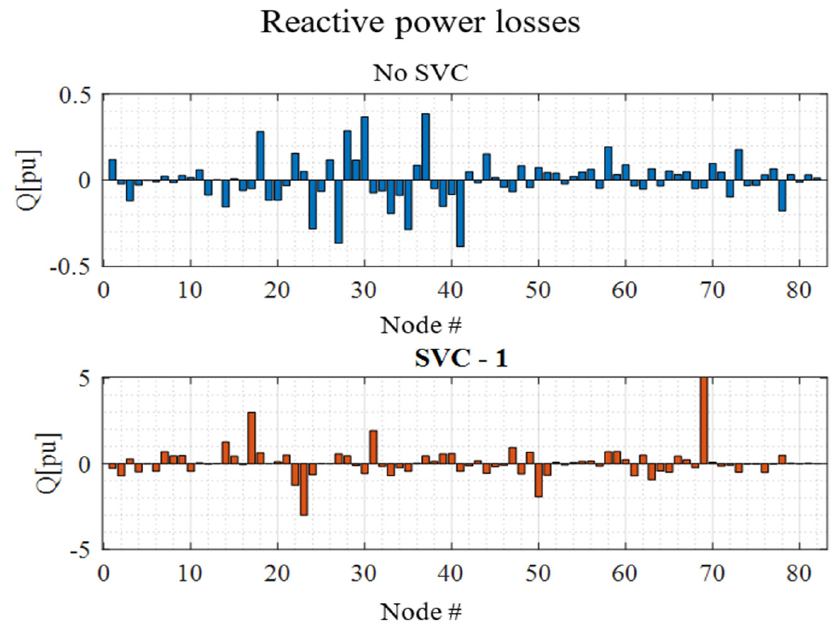
Figure 20. Profile of nodal reactive power for the IEEE 30-bus test system.